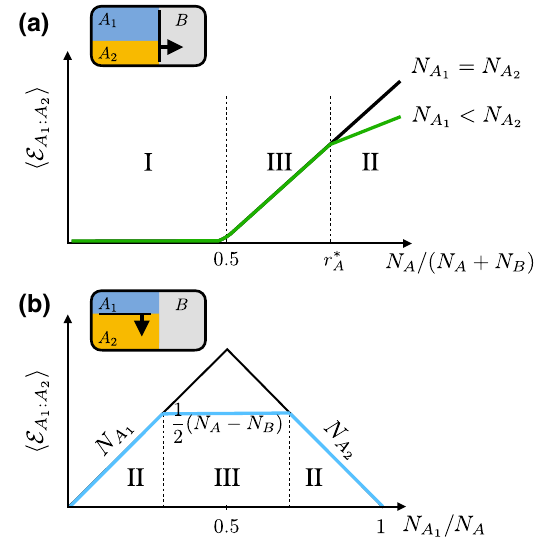
FIG. 3. Logarithmic negativity between subsystems A 1 and A 2 (a) as we increase the size of A while keeping the ratio N A fixed and (b) as we increase the size of A 1 while keeping N A / N B fixed. The corresponding paths [vertical for (a) and horizontal for (b)] are shown by arrows in Fig. 2. For reference in (b), we also show the Page curve in